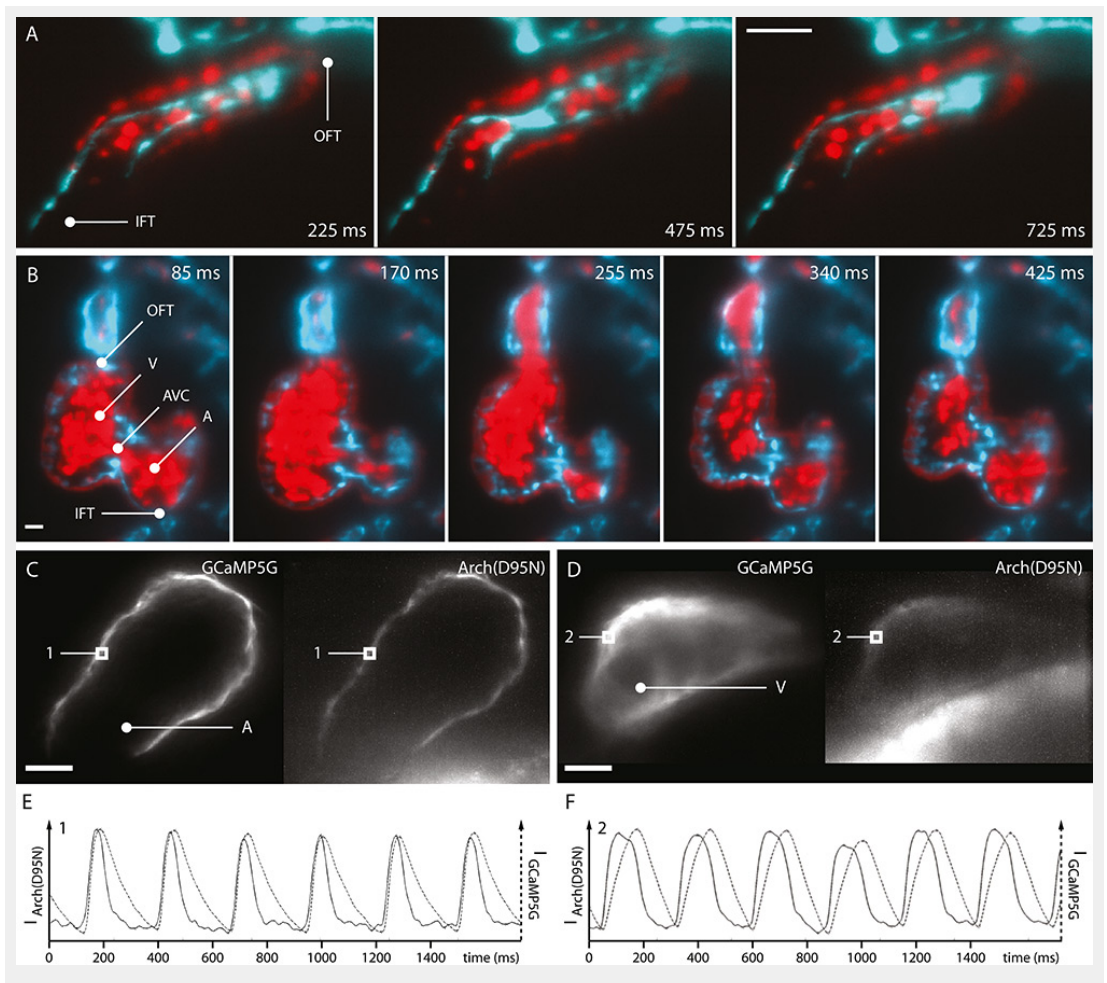
Figure 3 Optical sections of embryonic zebrafish hearts recorded with light sheet microscopy. A: 1 dpf transgenic Tg(kdrl:eGFP,myl7:dsRed, gata1a:dsRed) zebrafish. B: 4 dpf. C: Voltage and calcium imaging in the atrial myocardium of 2 dpf transgenic Tg(myl7:GCaMP5G-Arch(D95N) zebrafish, tnnt2a morpholino-injected. D: Ventricular myocardium. E: Action potentials and calcium transients in the atrial myocardium (position 1). F: Ventricular myocardium (position 2). Inflow tract (IFT), atrium (A), atrioventricular canal (AVC), ventricle (V), outflow tract (OFT). Scale bar: 20